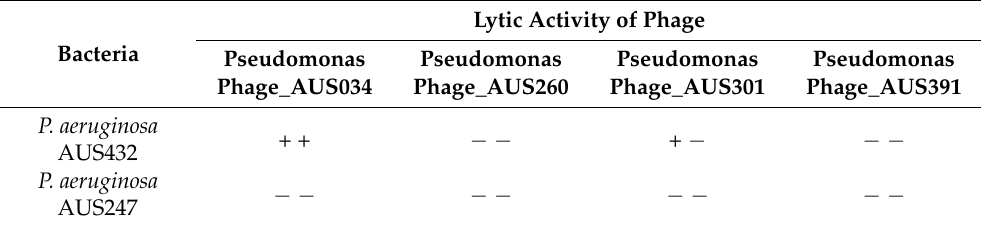
Table 6. Host range analysis of the isolated